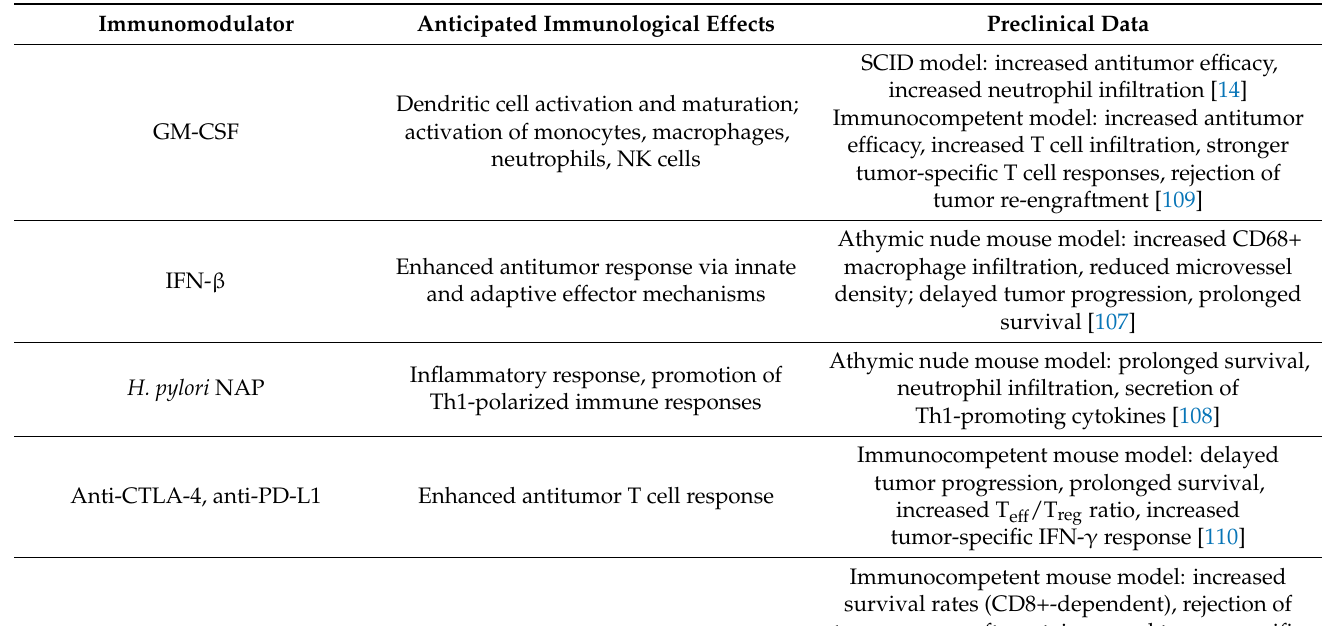
Table 1. Immunomodulatory oncolytic MeV. Overview of immunomodulatory transgenes that have been encoded in MeV, their anticipated immunological effects in the context of MeV oncolytic immunotherapy, and the outcome of the respective preclinical studies. GM-CSF: granulocyte–macrophage colony-stimulating factor; IFN: interferon; NAP: neutrophil activating protein; CTLA-4: cytotoxic T lymphocyte antigen-4; PD-L1: programmed cell death 1-ligand 1; Th: T helper cell; T eff : effector T cell; T reg : regulatory T cell; IL: interleukin; AICD: activation-induced cell death; BiTE: bispecific T cell engager; TAA: tumor-associated antigen; IFNAR: IFN- α